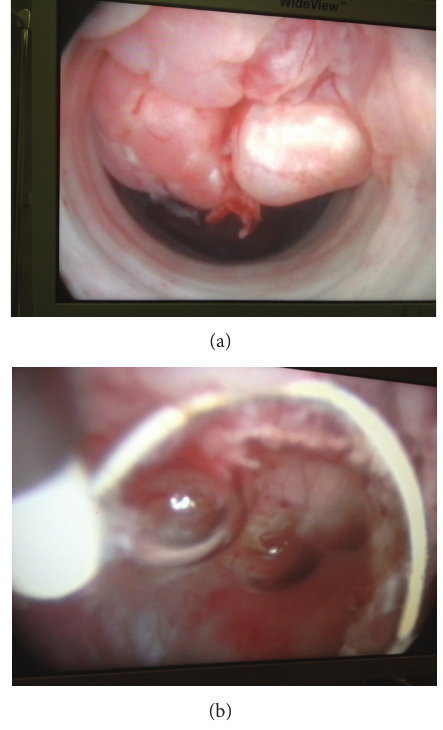
Figure 3: First step: endoscopic surgery. (a) Appearance of sessile- nodular lesion between the distal bulbar urethra and proximal penile urethra. (b) Surgical bed after endoscopic